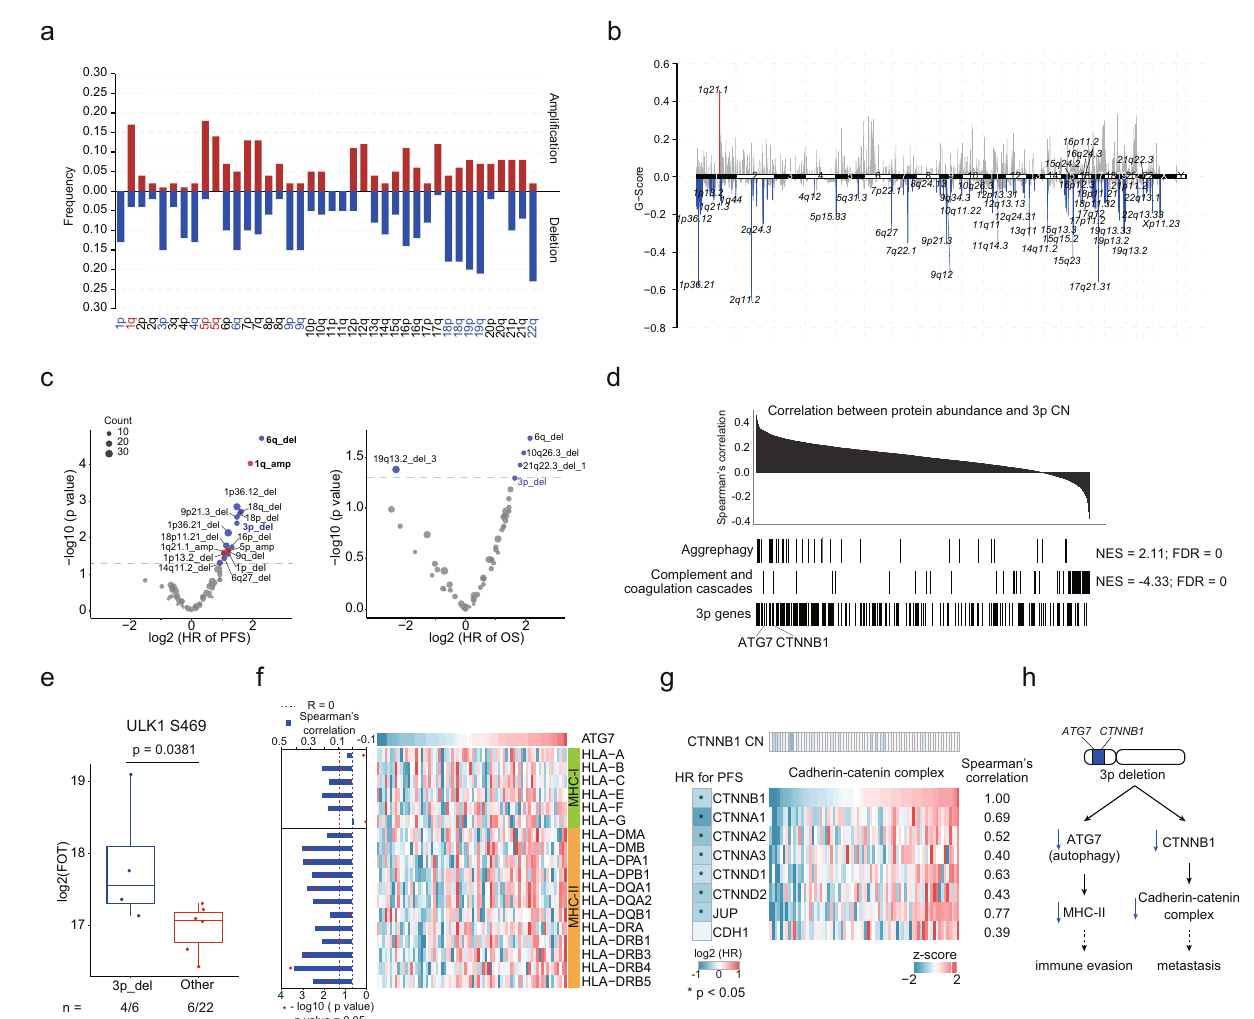
Fig. 4 | Somatic copy number alteration analysis in tRCC cohort. a Arm-level SCNA events. Red denotes ampli fi cation and blue denotes deletion. Signi fi cant events are highlighted using red and blue ( q <0.10). b Focal SCNA events. Focal peaks with signi fi cant copy number ampli fi cations (red) and deletions (blue) ( q <0.05) are shown. c Cox regression analysis of signi fi cant arm-level CNA and focal CNA events. d Identifying cis- and trans -effect of 3p deletion. Proteins are ranked based on the correlation between protein abundance and 3p CN. e Trans -